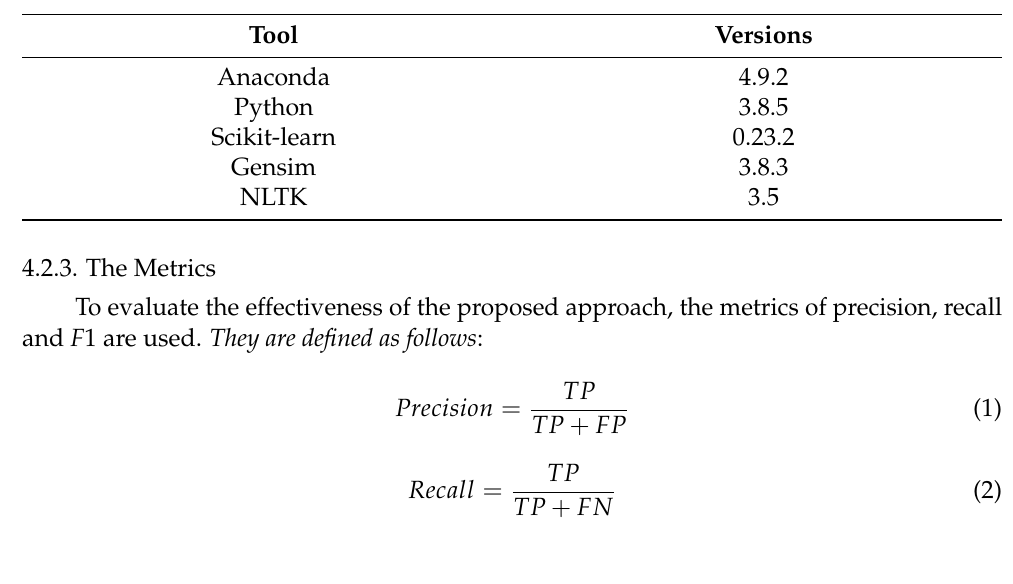
Table 2. The versions of the